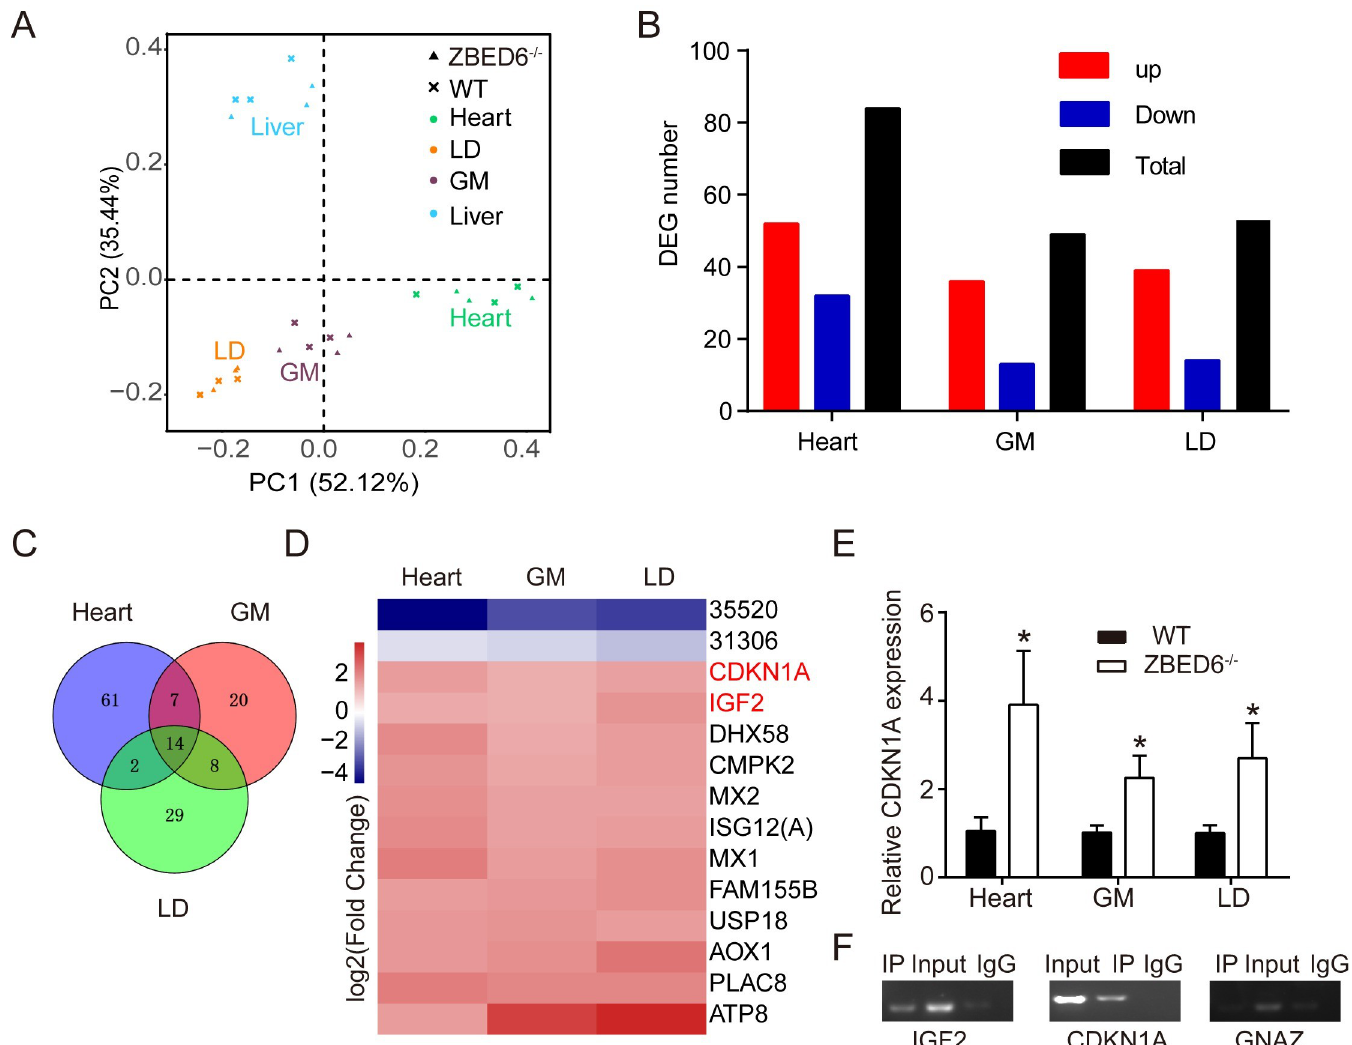
Fig 4. The regulation of ZBED6 in the muscle. (n = 3). Gastrocnemius muscle (GM), longissimus dorsi (LD). (A) PCA of the expressed genes of multiple tissues in WT and ZBED6 -/- pigs. (B) Number of DEGs in heart, GM and LD in ZBED6 -/- pigs. (C) Overlap DEGs in heart, GM and LD. (D) Heatmap of common 14 DEGs in heart, GM and LD. 35520 and 31306 are two ensemble ID, ENSSSCG00000035520 and ENSSSCG00000031306. The genes in red type contain at least one ZBED6 ChIP-seq peak. (E) qPCR analysis of CDKN1A mRNA in the heart, GM and LD from ZBED6 -/- pigs. (F) ChIP-PCR analysis in gastrocnemius muscle of ZBED6 occupancy at the binding sites of IGF2 , CDKN1A and GNAZ . The results are the means ± SEMs. � p < 0.05; �� p < 0.01, ��� p < 0.001,Student’s t